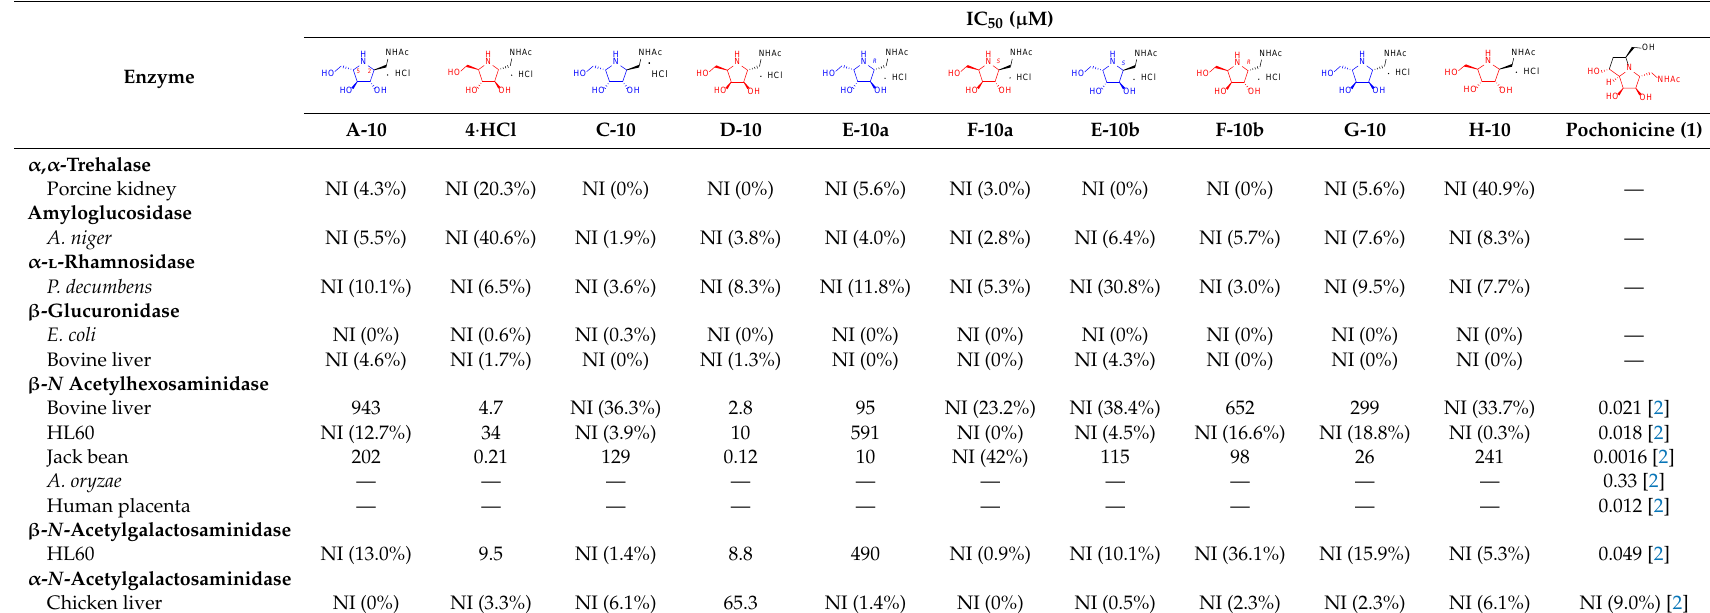
Table 2. Concentrations of 1- N -acetylamino pyrrolidine analogues giving 50% inhibition of various enzymes.